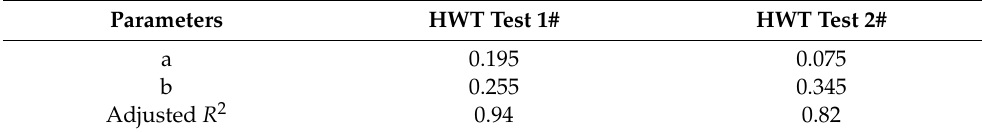
Table 6. The regression results of HWT test.